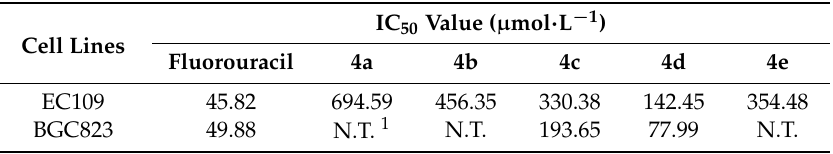
Table 3. The cytotoxicity of compounds 4a – e .